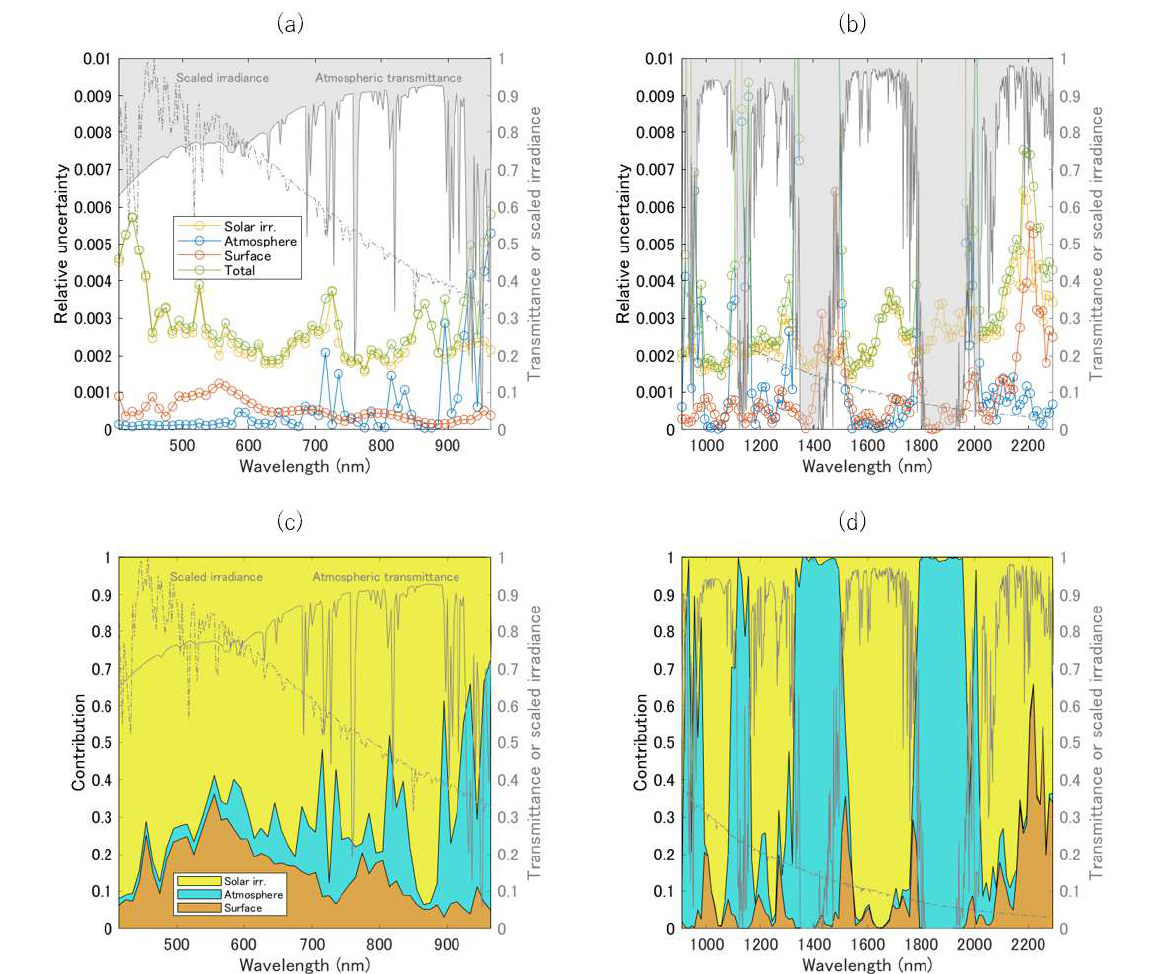
Figure 4. ( a ) Plot of the approximated uncertainties in the relative values obtained from each layer (exo-atmosphere, atmosphere, and surface) and the total uncertainties of the approximations in relative values for the HISUI VNIR band region at a lower standard deviation for the solar irradiance models (Case-1). ( b ) The same plot for the HISUI SWIR region ( < 2300 nm). ( c ) Plot of the relative contributions of the uncertainties in each layer to the total uncertainties in the VNIR region for Case-1 of the solar irradiance model. ( d ) The same plot for the SWIR region ( < 2300